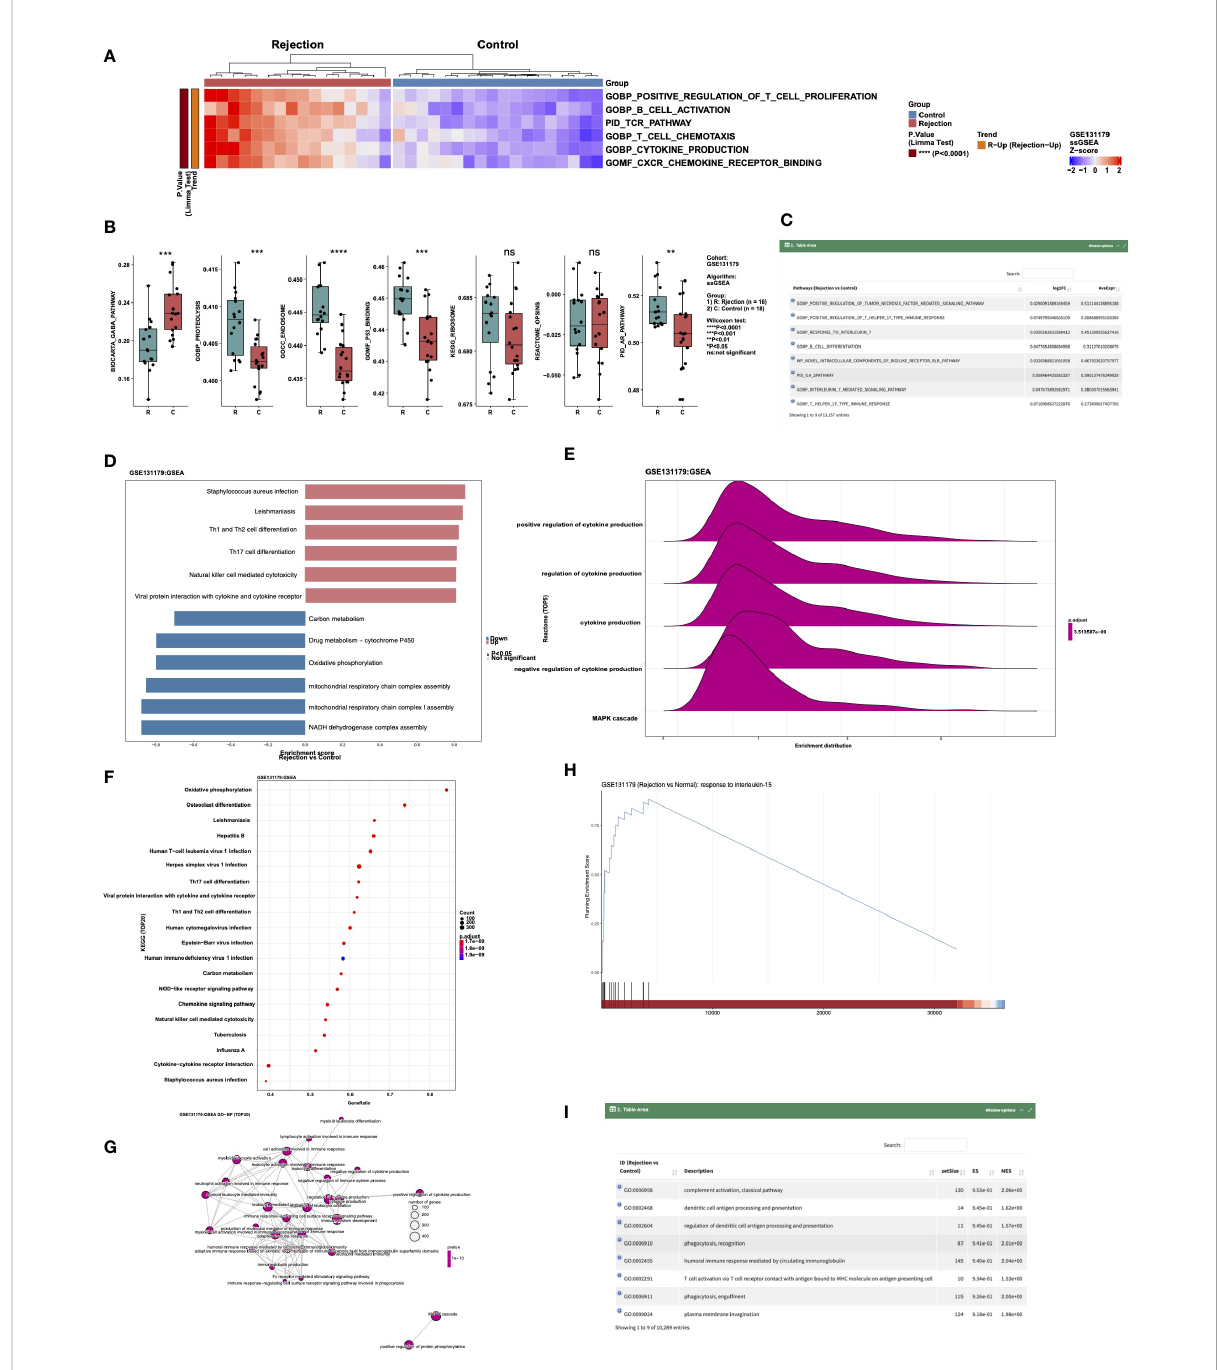
FIGURE 5 An example of the “ Enrichment Analysis ” tab. (A) Heatmap showing the differences in the scores of ssGSEA Pathways (GOBP_POSITIVE_ REGULATION_OF_T_CELL_PROLIFERATION, GOBP_B_CELL_ACTIVATION. PID_TCR_PATHWAY GOBP_T_CELL_CHEMOTAXIS, GOBP_ CYTOKINE_PRODUCTION and GOMF_CXCR_CHEMOKINE_RECEPTOR_BINDING) between rejection and control groups in cohort GSE131179. (B) Boxplot showing the difference in the scores of ssGSEA Pathways BIOCARTA_GABA_PATHWAY, GOBP_PROTEOLYSIS, GOCC_ENDOSOME, GOMF_P53_BINDING, KEGG_RIBOSOME, REACTOME_OPSINS, and PID_AR_PATHWAY between rejection and control groups in the GSE131179 cohort. (C) Data table showing the differences in the scores of the ssGSEA Pathways between rejection and control groups in the GSE131179 cohort. (D – H) Barplot (D) , ridgeline plot (E) , dot plot (F) , emap plot (G) , GSEA plot (H) and data table (I) of the GSEA result in cohort